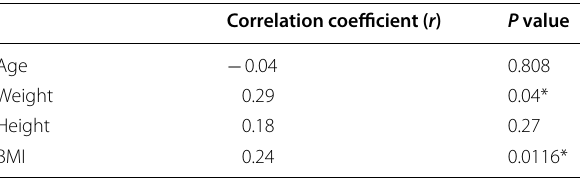
Table 3 Correlation between patient characteristics and effective dose of ICA